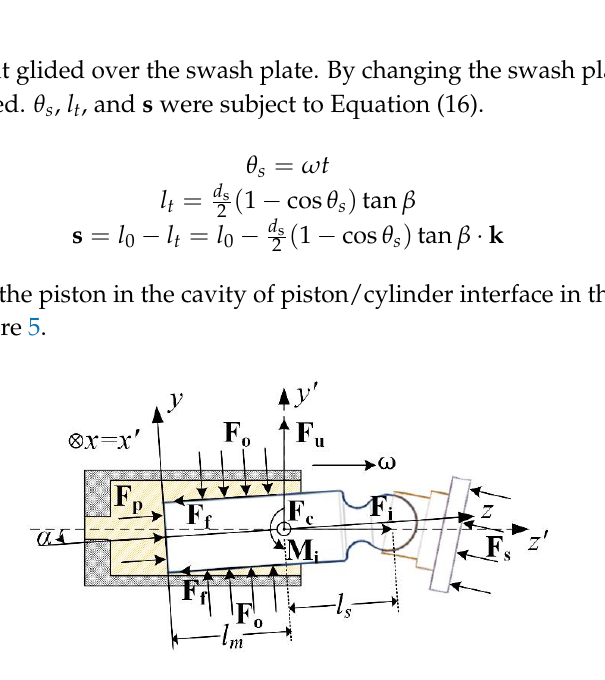
Figure 5. Graph of mechanical analysis.